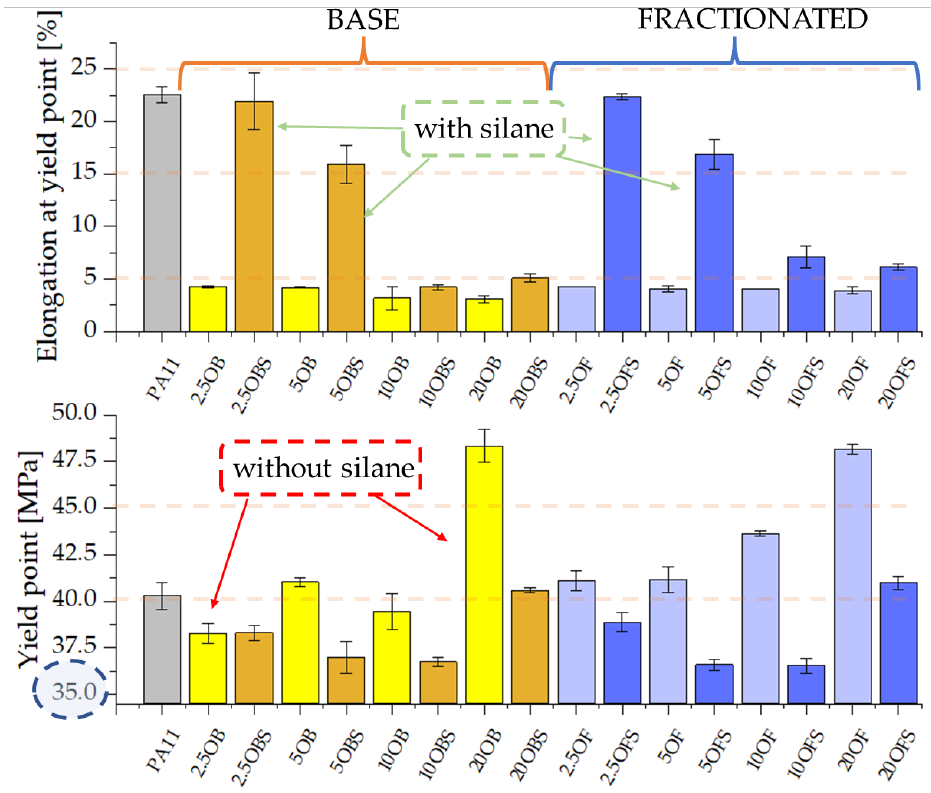
Figure 7. Elongation at yield point and yield point of PA11 composites contining silanized and non-silanized diatomite.